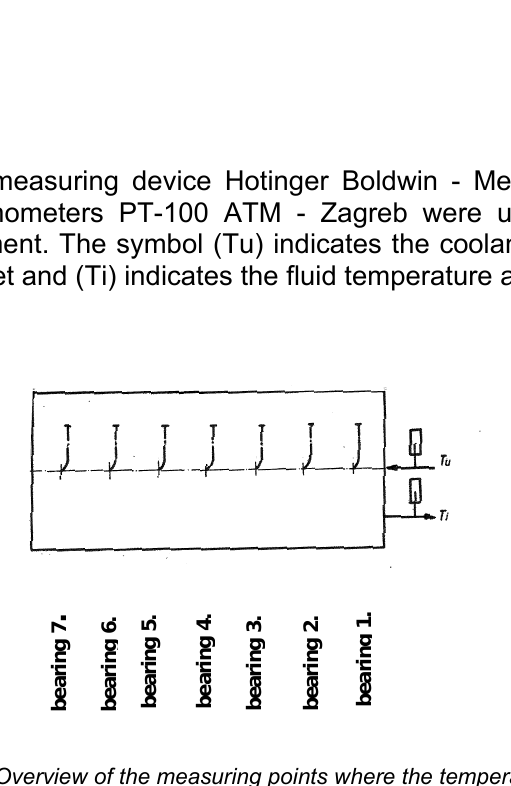
Figure 10 – Overview of the measuring points where the temperature measurement of the main bearings of the engine crankshaft was